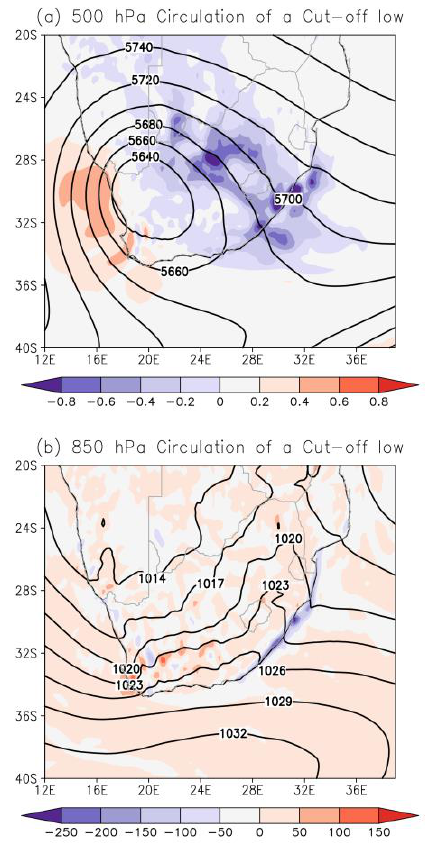
Figure 3. ( a ) Typical 500 hPa geopotential height (m) and omega (Pa/m) and ( b ) near-surface MSLP (hPa) and divergence ( × 10 − 6 s − 1 ) circulation associated with a cut-off low over South Africa [24]. The variables plotted here were obtained from the ECMWF ERA5 reanalysis